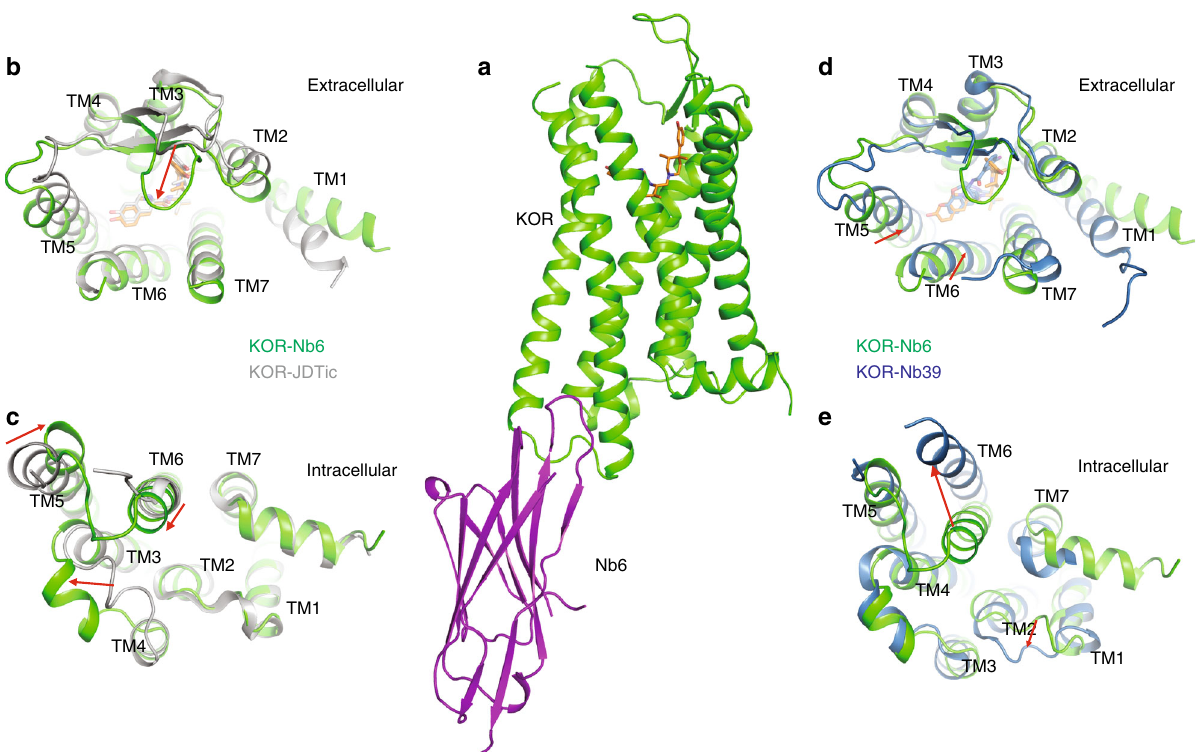
Fig. 2 Overall alignment of KOR – Nb6 and KOR – JDTic and KOR – Nb39 structures. a Overall architecture of KOR – JDTic – Nb6 complex. The receptor is shown in green, Nb6 in purple, and JDTic in orange. b , c Extracellular ( b ) and intracellular ( c ) views of structural alignment of KOR – Nb6 complex (green) and KOR – JDTic inactive state (gray; PDB ID code 4DJH). d , e Extracellular ( d ) and intracellular ( e ) views of a structural alignment KOR – Nb6 complex (green) and KOR – Nb39 active state (blue; PDB ID code 6B73). Major structural differences are shown as red arrows